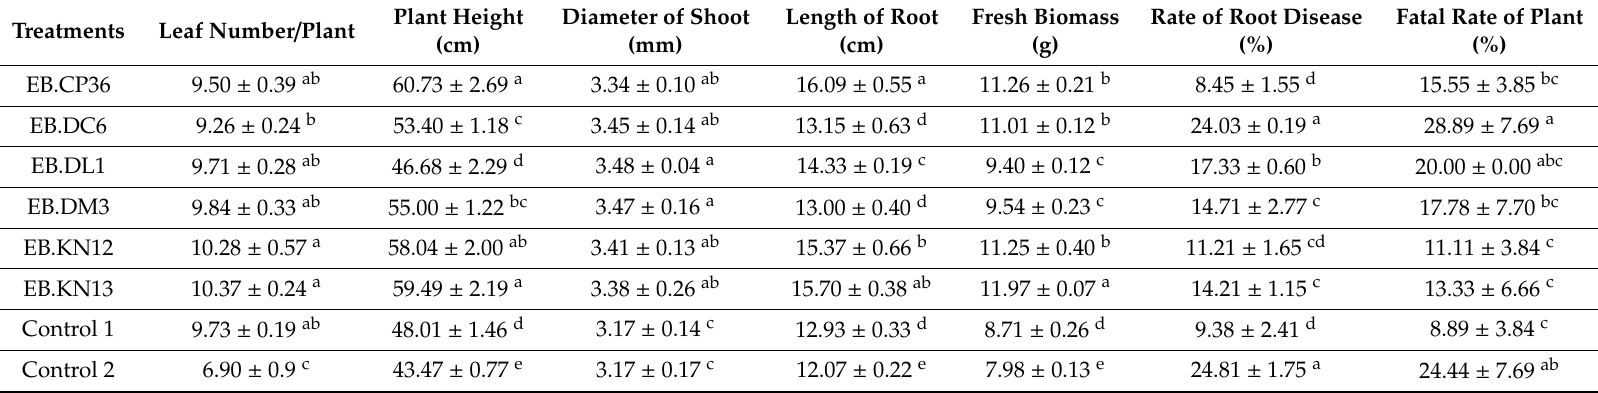
Table 4. E ff ect of the endophytic bacteria on the growth and Phytophthora resistance of black pepper seedlings in the greenhouse.